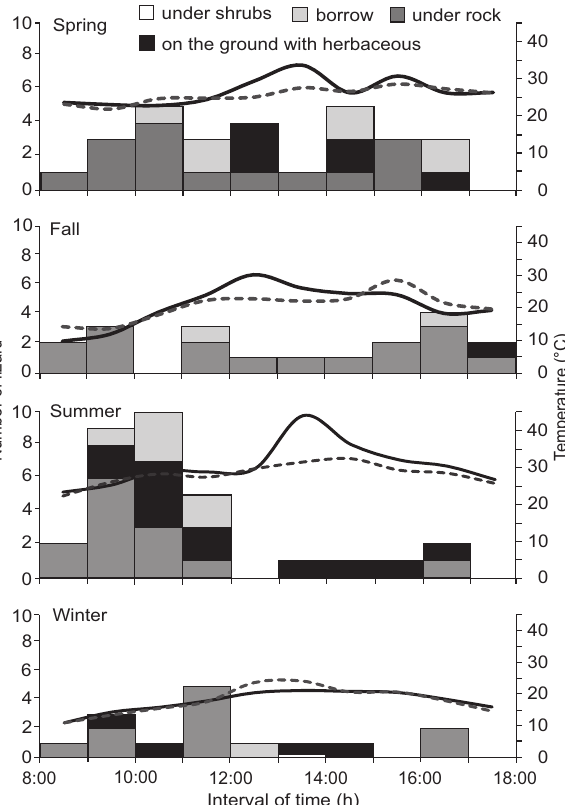
Figure 2. Microhabitat use by C. vacariensis and hourly mean of environmental temperatures (air temperature: continuous line, substrate temperature: broken line) throughout the seasons in the study area, municipality of Bom Jesus between October 2006 and September